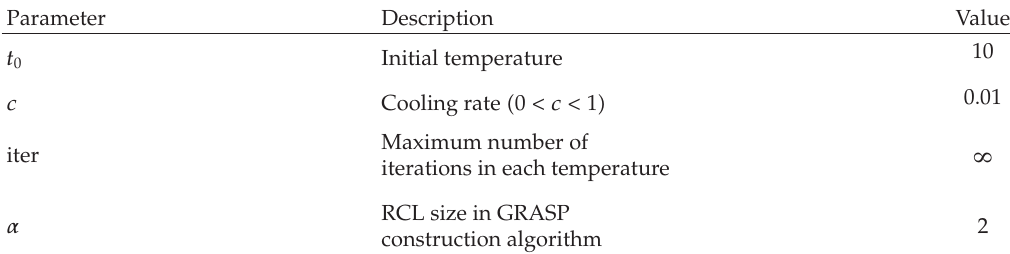
Table 6: The best value of hybrid heuristic algorithm